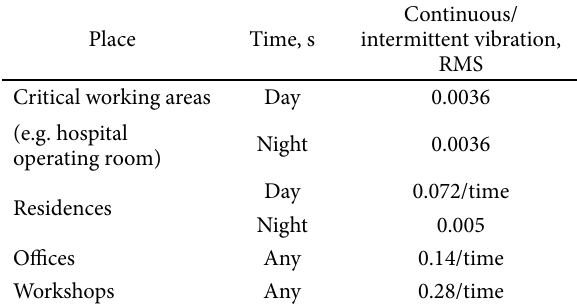
Table 1. Max RMS frequency-weighed acceleration ( ISO 2631:1997 ) Place